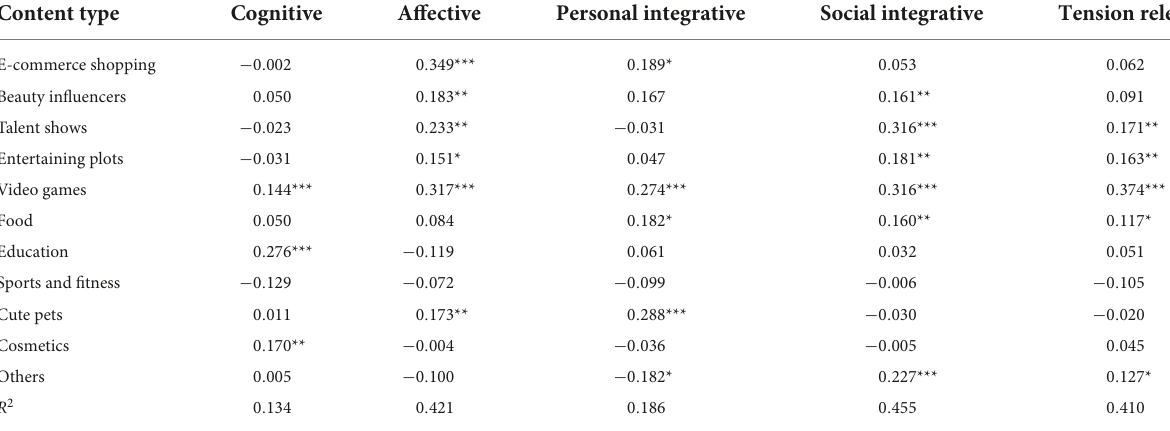
TABLE 3 Direct effects of content types on gratifications.